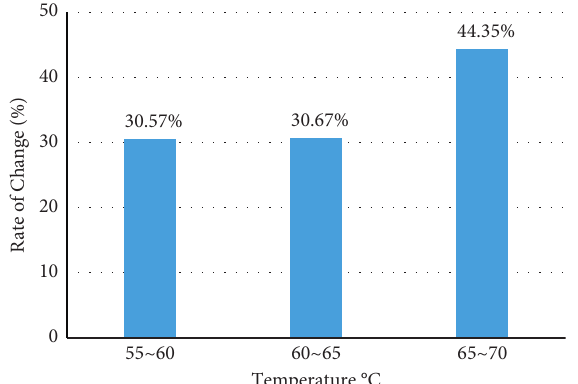
Figure 2: Percentage decrease in DS caused by the increase in temperature.